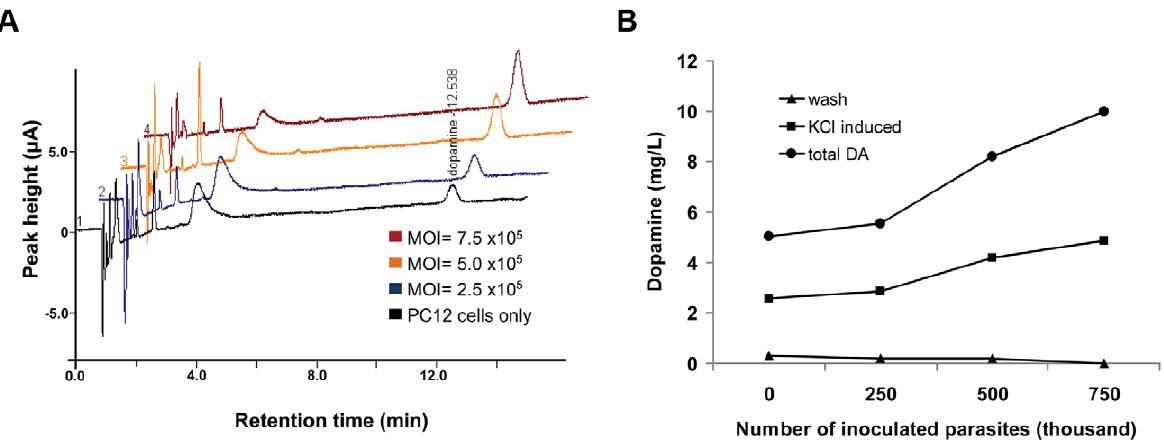
Figure 3. Elevated dopamine from T.gondii infected dopaminergic cells. (A) Overlay of HPLC-ED chromatograms derived from PC12 cells DA release assay, where cells were infected with increasing numbers of induced tachyzoites. PC12 cells are the classic dopaminergic neuron model since they contain all the machinery for dopamine synthesis, packaging and release. Equivalent numbers of cells were infected with T. gondii (brown, 7.5 6 10 5 ; yellow, 5 6 10 5 ; blue, 2.5 6 10 5 ; and black, control) and incubated for 5 days followed by assaying DA release in high K + buffer. Increased dopamine was released from infected cultures. The amount of dopamine released is correlated with number of parasites in the culture. The experiment was repeated several times (n=4) with a representative experiment shown. (B) Graph of dopamine released from the K + induced cultures (squares) described in A. The total dopamine measured in each of the cultures is shown (circles). The dopamine measured in the low KCl wash buffer for each culture is also plotted (triangles).